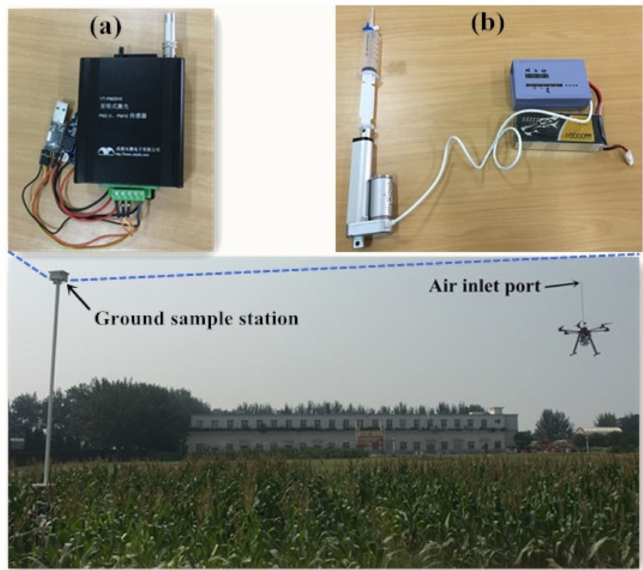
Figure 4. Image showing flight operation experiments on Septeimber 3, 2019. ( a ) Particulate matter sensor in ground sample station. ( b ) Polypropylene syringes equipped with an automated lifter drawing bar in ground sample